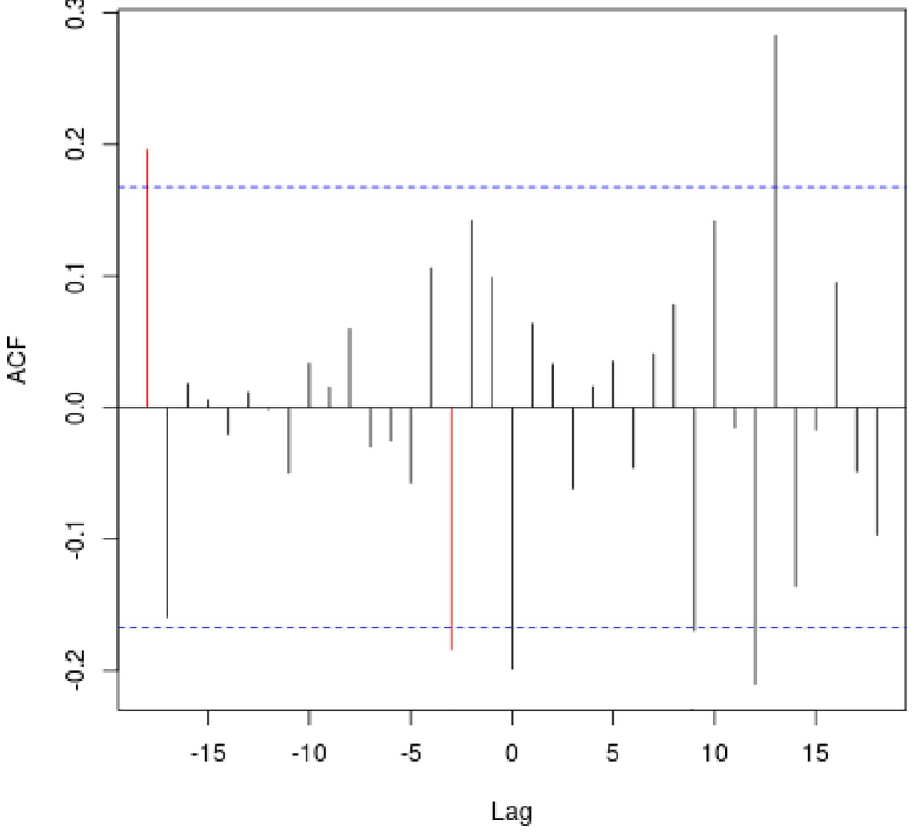
Fig 4. Correlation between lagged drought severity and twitter